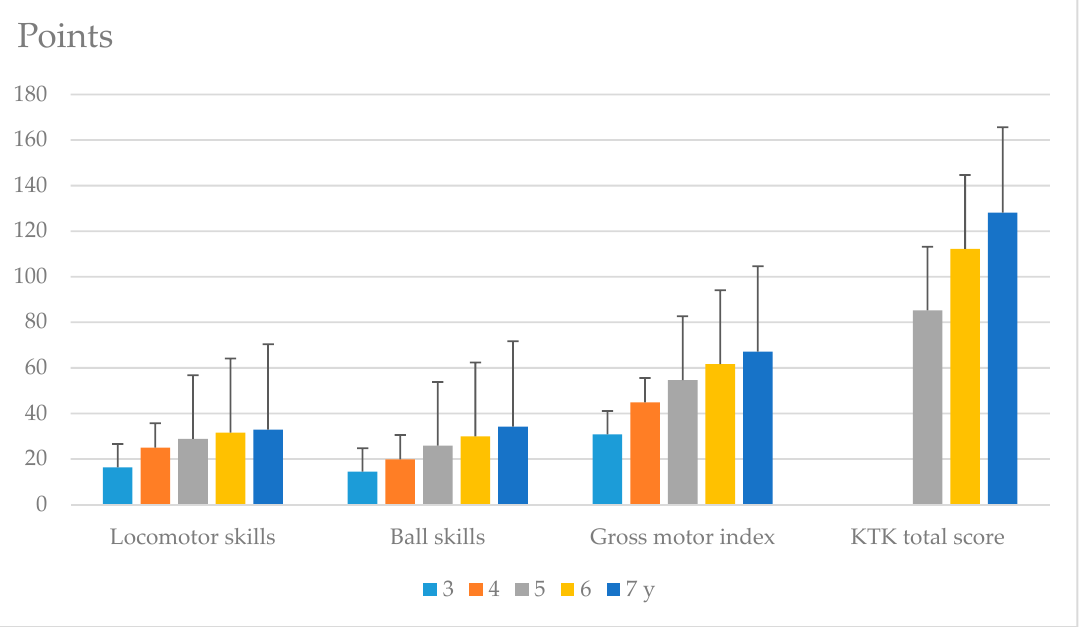
Table 2. Individual, family and environmental correlates associated with children’s TGMD-3 total score.